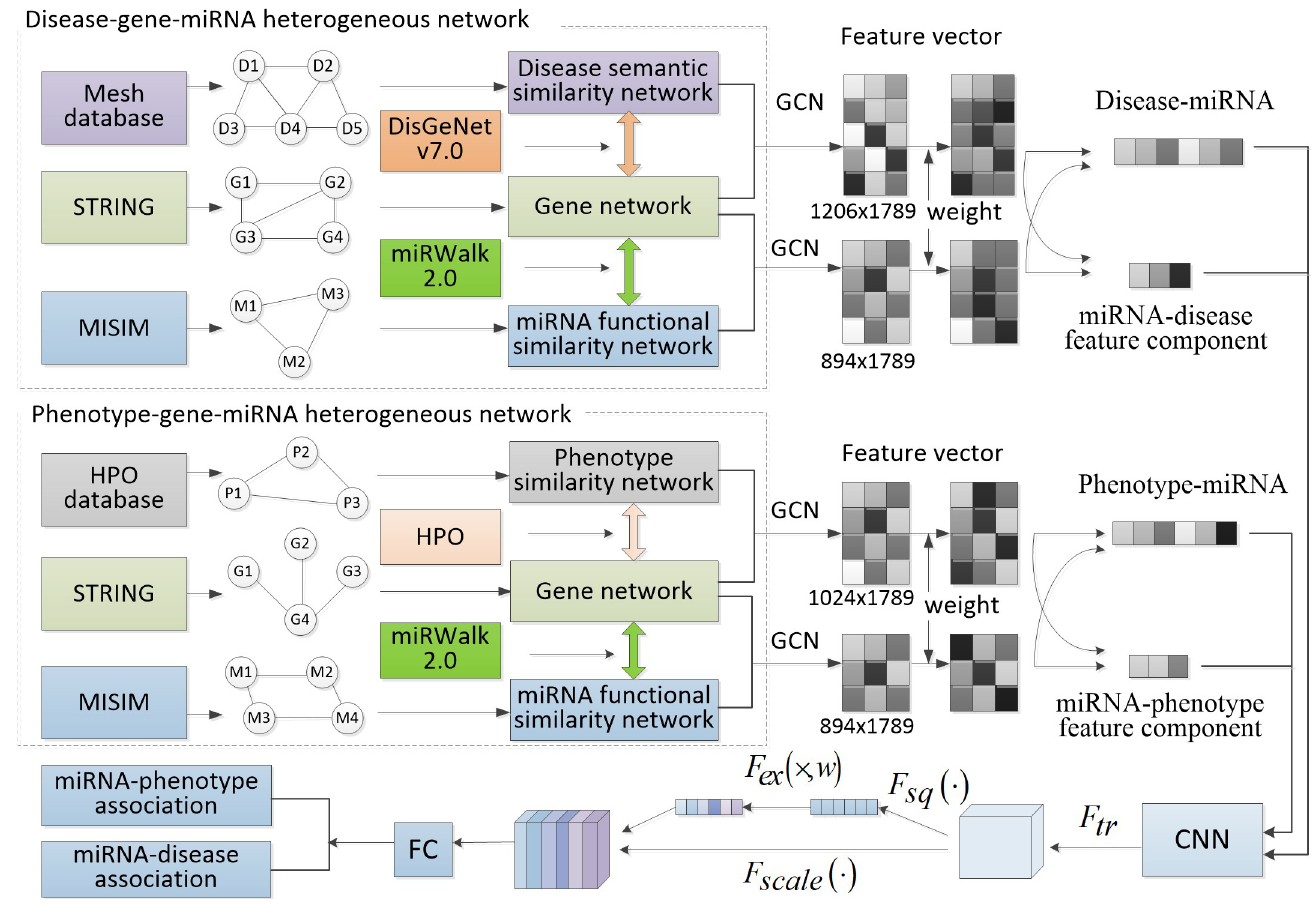
Fig 2. The framework of